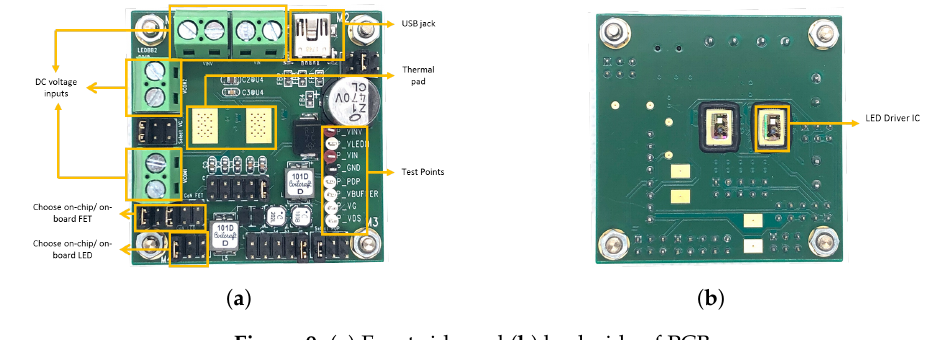
Figure 9. ( a ) Front side and ( b ) back side of